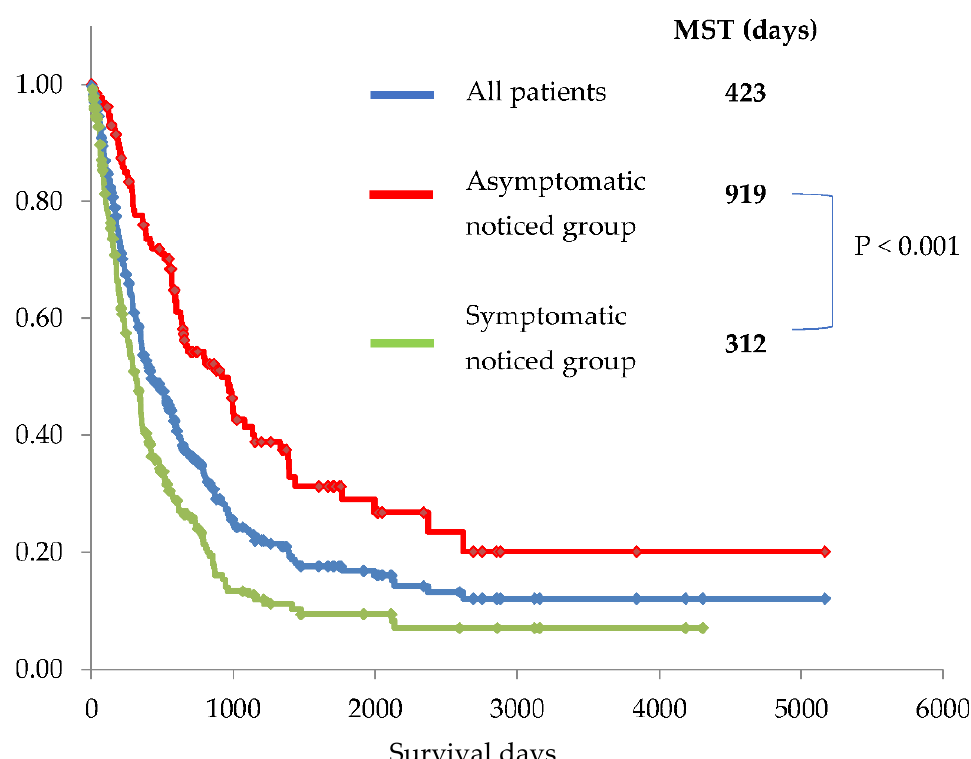
Figure 3. Kaplan–Meier curves for all patients (blue line), symptomatic group (group 1 + 2) (green line), and asymptomatic group (group 3–8) (red line). The median survival time (MST) was signifi- cantly longer, and 5-year overall survival rate was significantly higher in the asymptomatic group than in the symptomatic group (312 days vs. 919 days and 5.4% vs. 29.0%, p < 0.001, respectively).